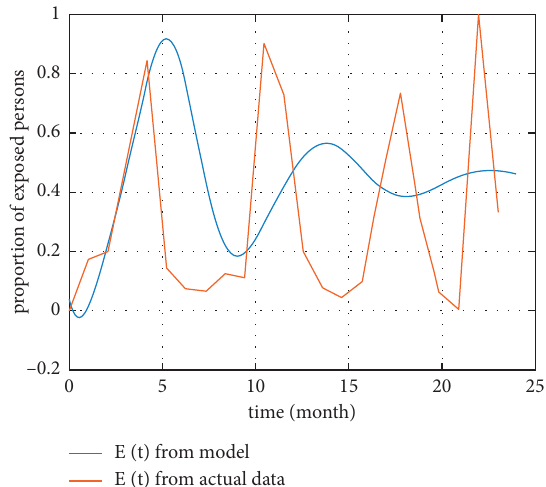
Figure 10: Proportion of exposed curves from normalized data and the model.